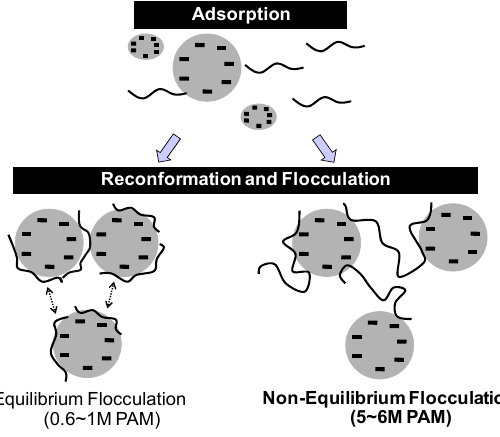
Figure 3. Schematic diagram of equilibrium and nonequilibrium flocculation mechanisms in kaolinite suspensions dosed with